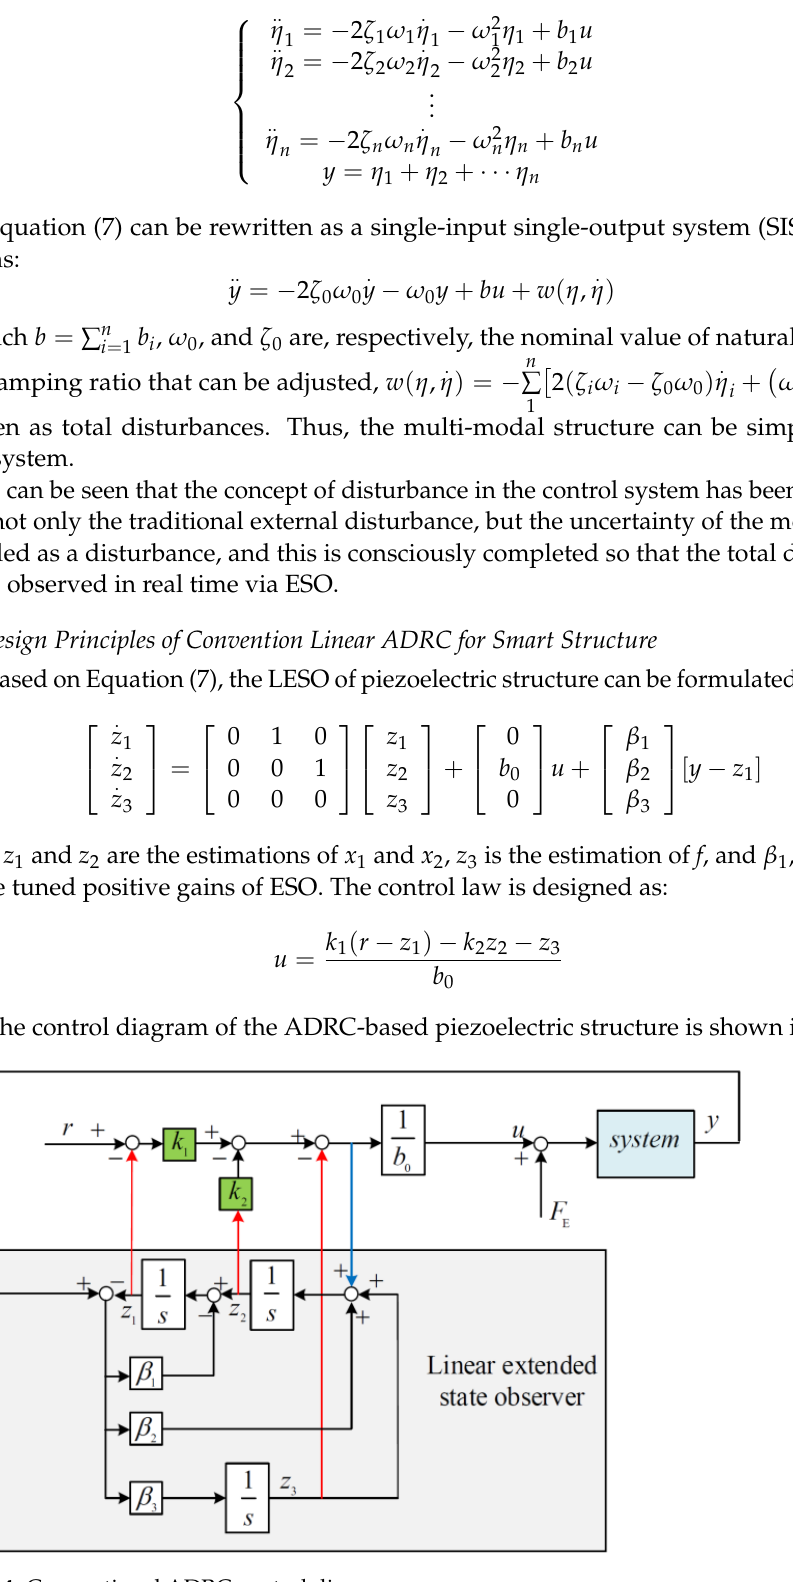
Figure 4. Conventional ADRC control diagram.